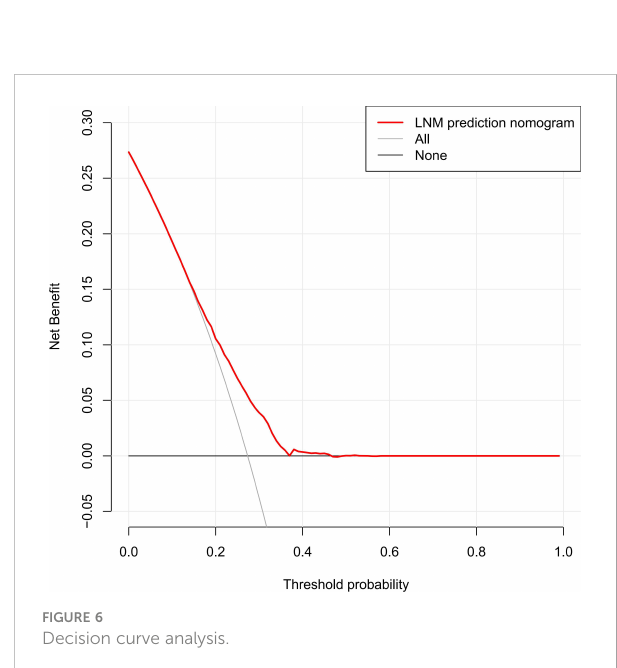
FIGURE 6 Decision curve